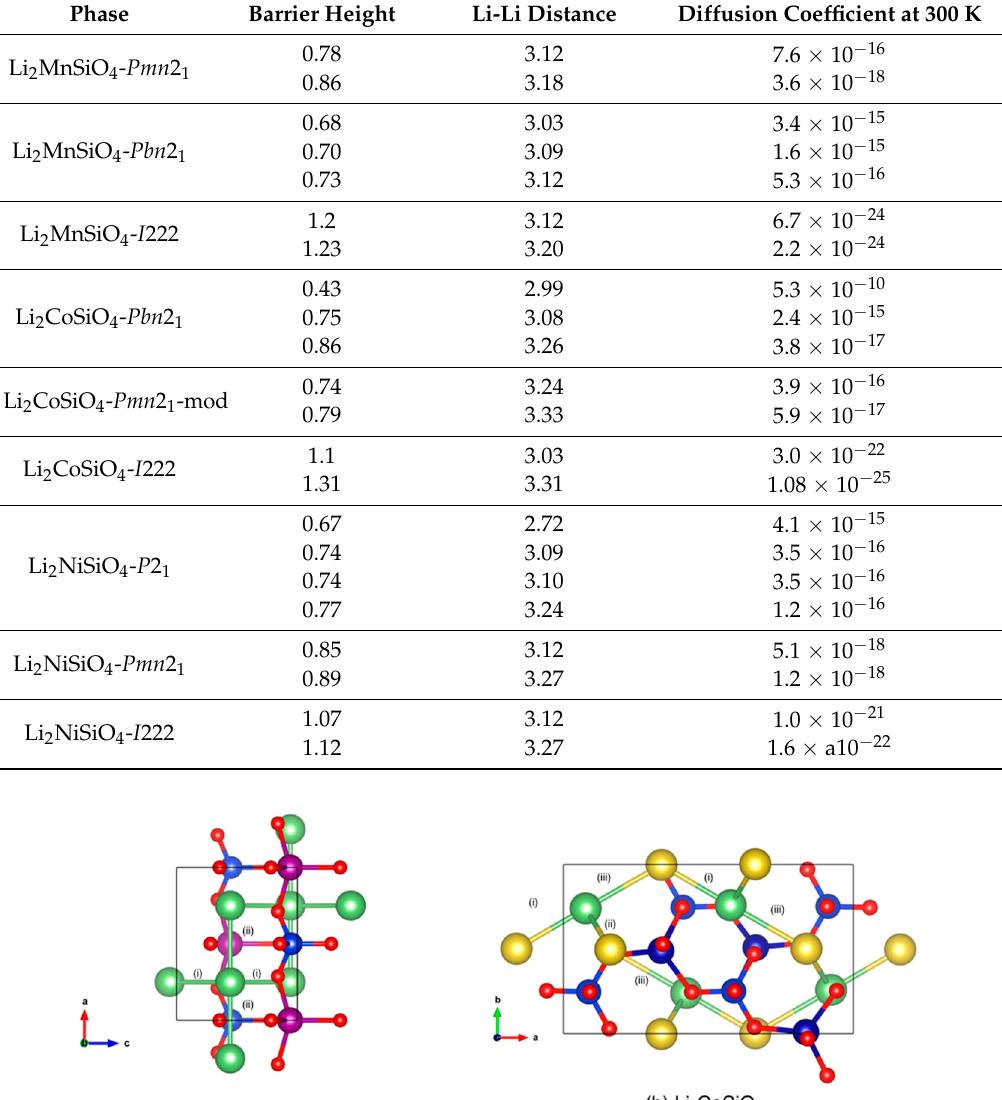
Table 5. Calculated barrier height (in eV), Li-Li migration distance (in Å), and diffusion coefficient (D; cm 2 s − 1 ) for Li 2 M SiO 4 phases.